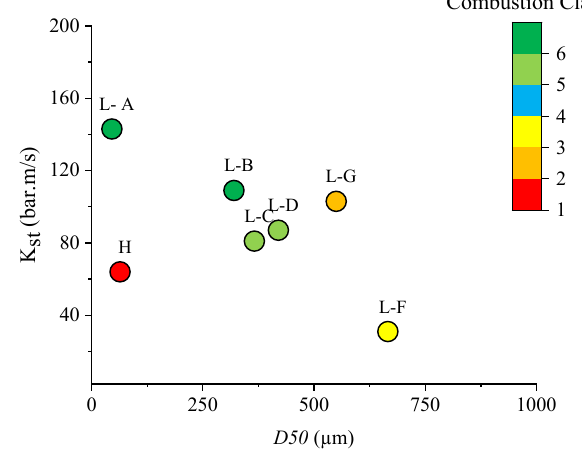
Figure 9. The Combustion Class versus the deflagration